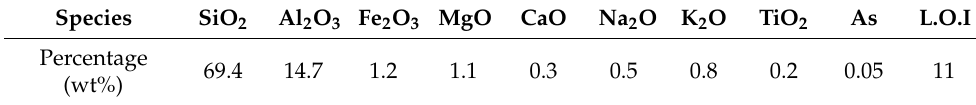
Table 1. Chemical compositions of the Algerian montmorillonite used [41].